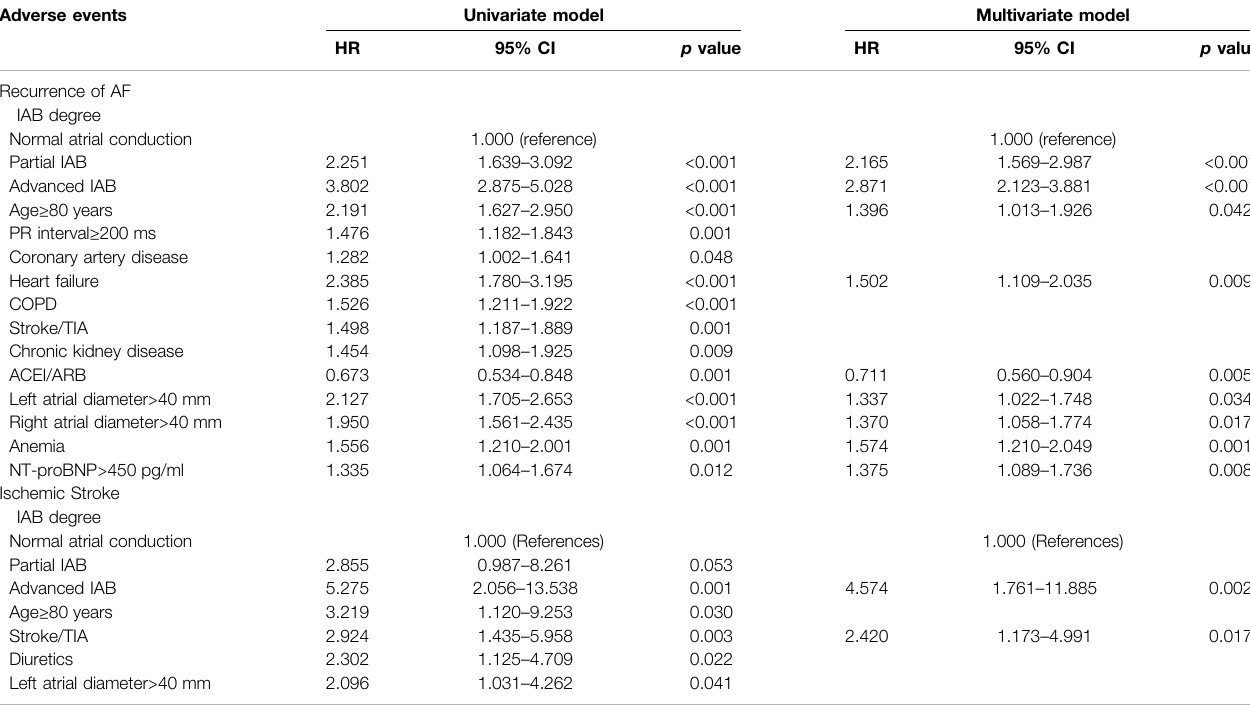
TABLE 4 | Univariate and Multivariate Cox Regression Analyses of Risk Factors for Recurrent AF and Ischemic Stroke in elderly patients with hypertension during follow-up. Adverse events Univariate model Multivariate model HR 95% CI p value HR 95% CI p